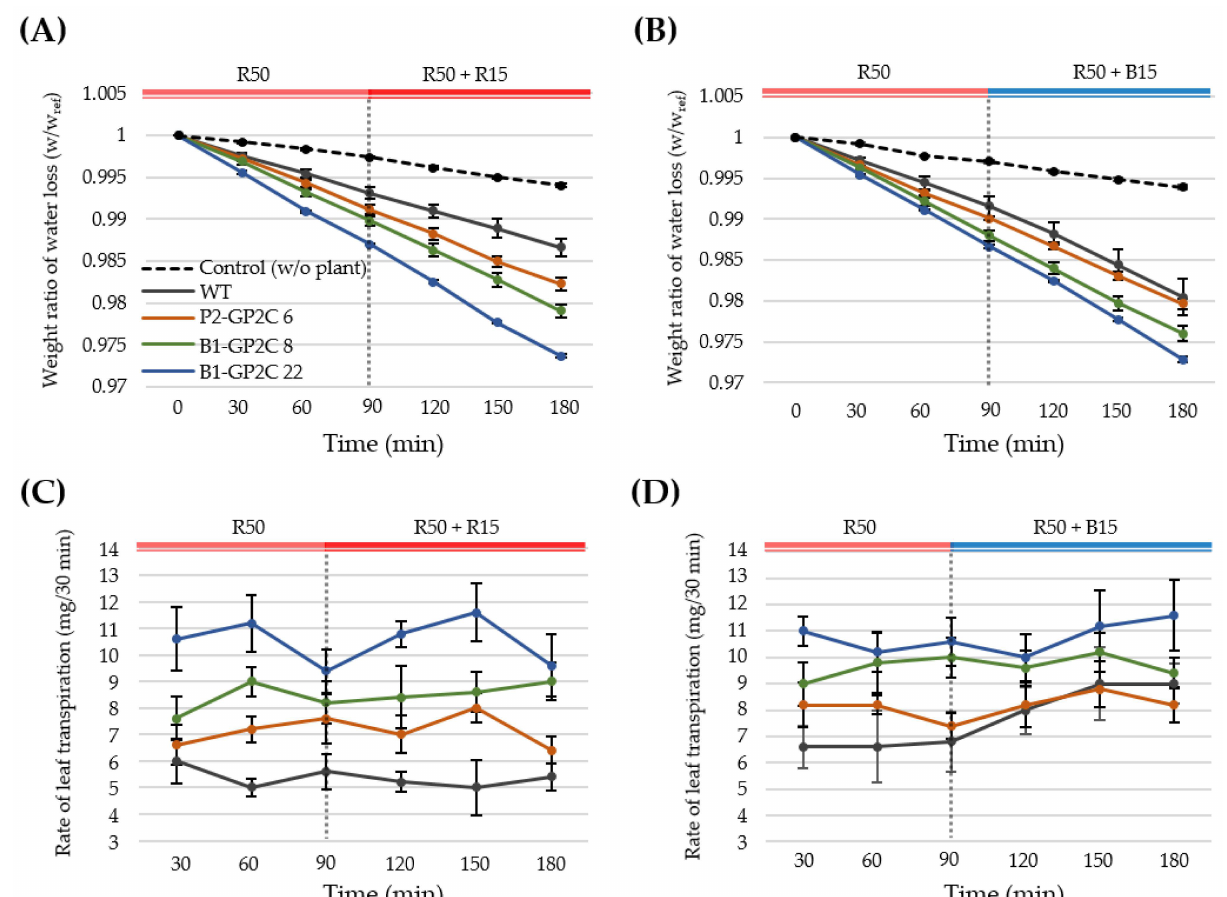
Figure 6. Leaf transpirations in P2-GP2C and B1-GP2C plants. ( A ) Temporal changes in weight loss by leaf transpiration measured at 30 min intervals for 90 min under red light (R50, 50 µ mol m − 2 s − 1 ) and for an additional 90 min under red light (15 µ mol m − 2 s − 1 ) superimposed on red light (R50 + R15, 50 µ mol m − 2 s − 1 ). ( B ) Temporal changes in weight loss by leaf transpiration measured at 30 min intervals for 90 min under red light (R50, 50 µ mol m − 2 s − 1 ) and for an additional 90 min under blue light (15 µ mol m − 2 s − 1 ) superimposed on red light (R50 + B15, 50 µ mol m − 2 s − 1 ). Weight loss ratios were obtained from five plants at each time point. ( C ) Actual water reduction in the condition of ( A ). ( D ) Actual water reduction in the condition of ( B ). Data represent the mean ± SE ( n =